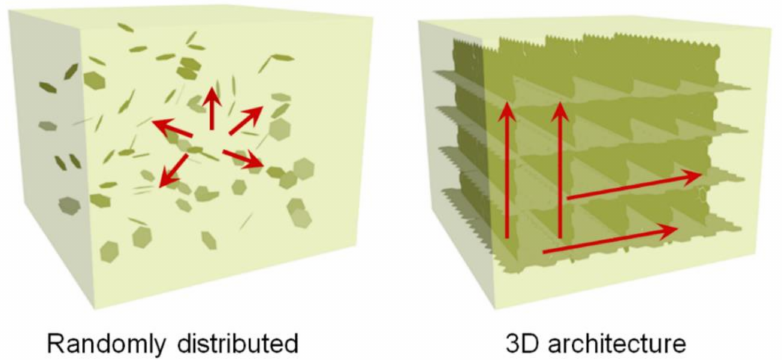
Figure 3. The thermal conductivity values of the recently published polymer composites with a continuous 3D architecture of carbon fillers are summarized in Table 1.